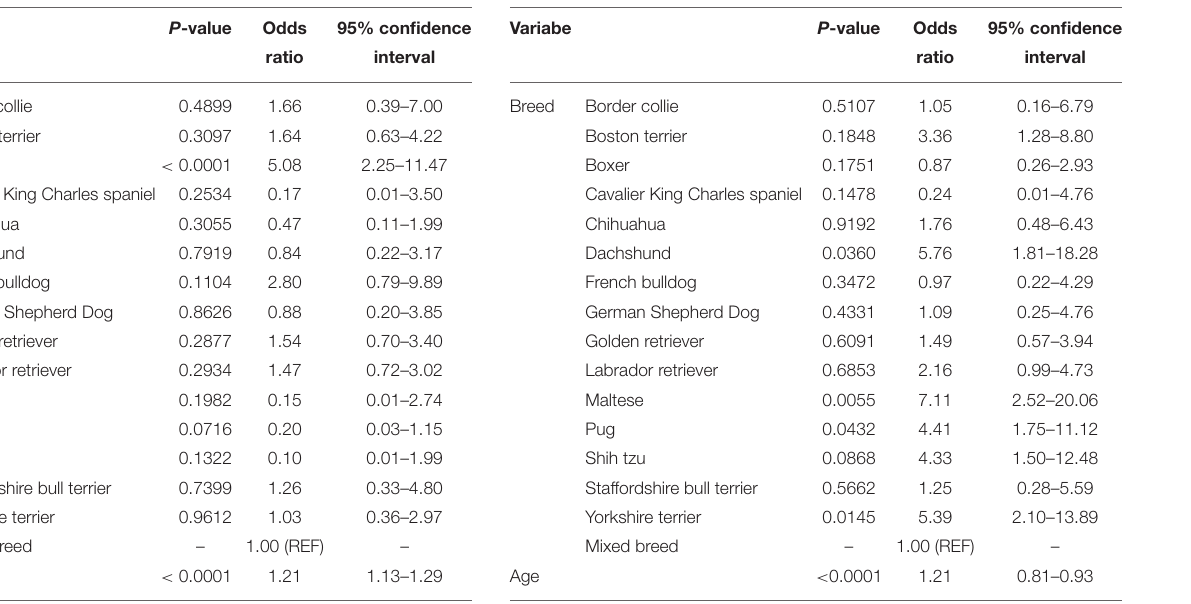
TABLE 3 | Breed-specific age-adjusted odds ratios and associated 95% confidence intervals for diagnosis of an intracranial mass in dogs undergoing brain imaging.